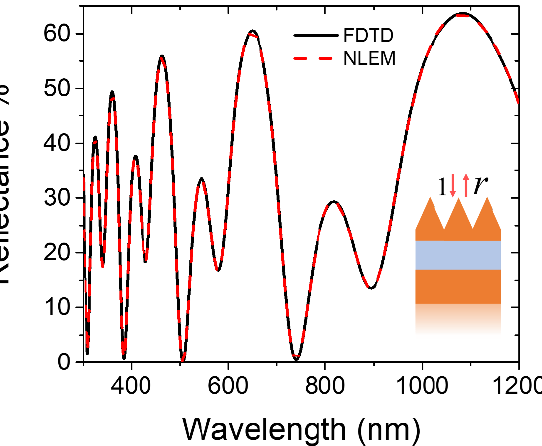
Figure 8. Different effective medium models are tested for predicting ( a ) the roughness height 𝐻 and ( b ) the roughness shape 𝑠 , by fitting to corresponding FDTD results. The second simulated test is a more complex structure consisting of three material layers. The top (film) and bottom (substrate) layer have an intermediate refractive index n = 3, while the middle one (spacer) has n =1.7. The thickness of the top film is 250 nm and of the spacer 500 nm. The morphology of the rough surface is assumed to be square periodic pyramids with period 𝐿 = 16 nm , 𝐻 = 48 nm, and shape 𝑠 = 1 (linear pyramid). An excellent agreement between the FDTD method and the NLEM model is achieved (Figure 9), with relative errors for the predicted size 𝐻 and shape 𝑠 close to −0 .5%.